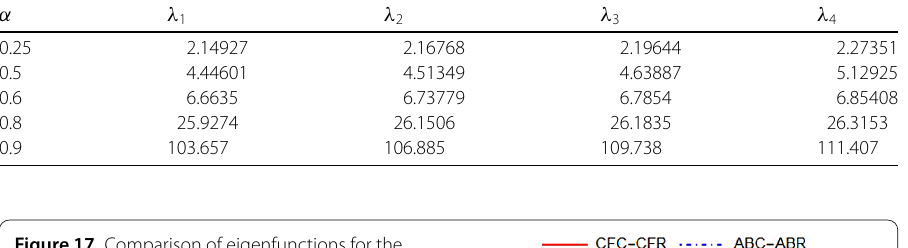
Figure 17 Comparison of eigenfunctions for the problem (12), (13)—(24), (25) α = 0.3, λ = 36, c 1 = c 3 = –1, q =